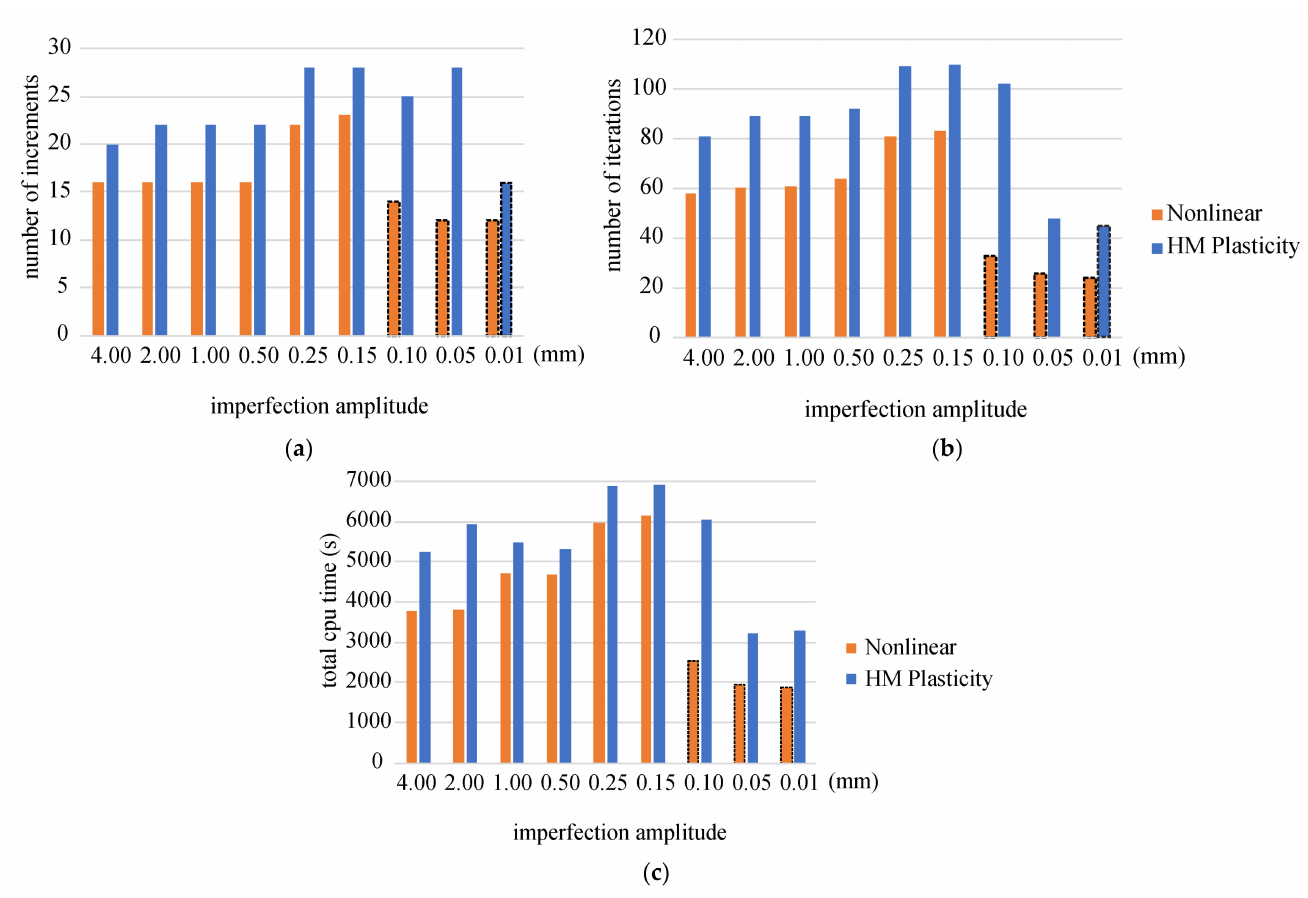
Figure 24. Number of: ( a ) increments, ( b ) iterations needed to solve the problem, ( c ) CPU time needed to solve the problem as a function of the amplitude for geometric